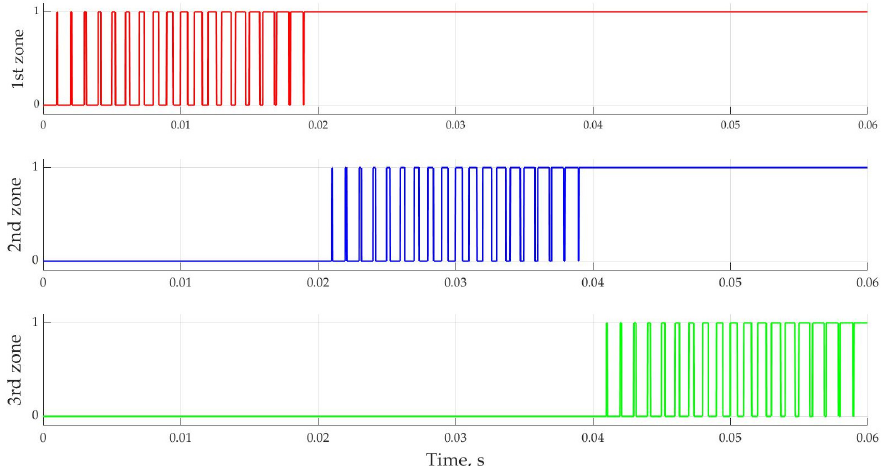
Figure 7. Oscillograms of control pulses in dynamics.